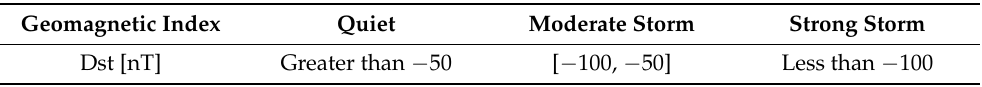
Table 1. Geomagnetic activity intensity threshold of Dst